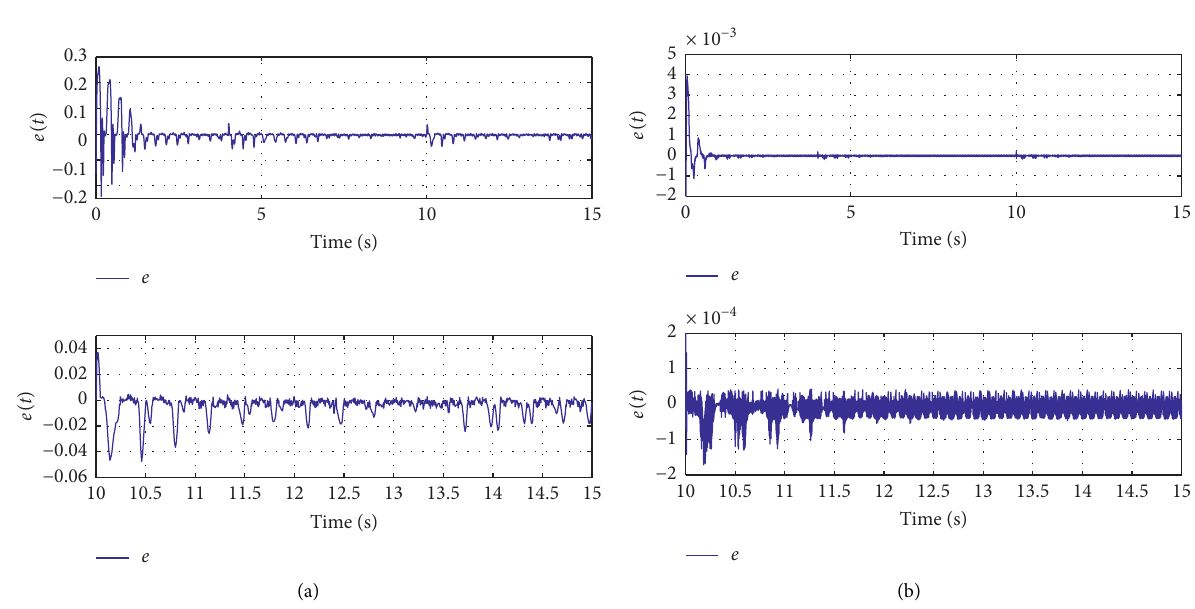
Figure 8: Tracking error of NN-NSM and NN-FFOSM in case